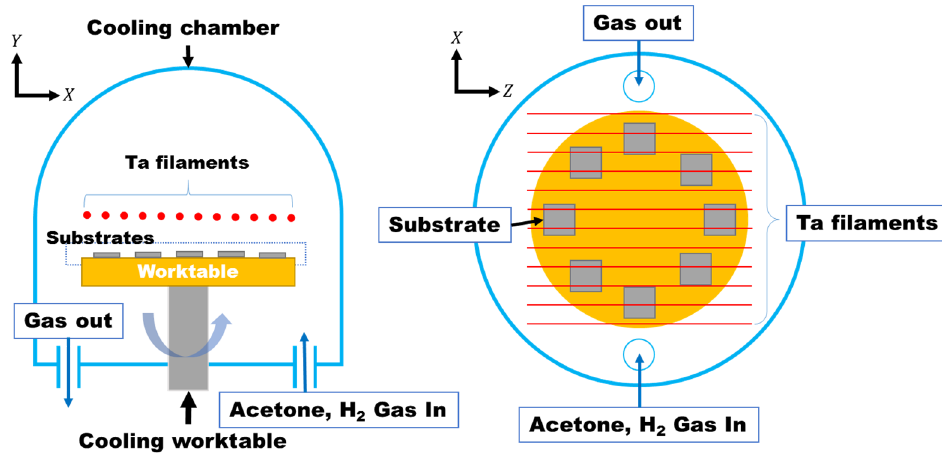
Figure 2. Schematic diagrams of the HF ‐ CVD system.